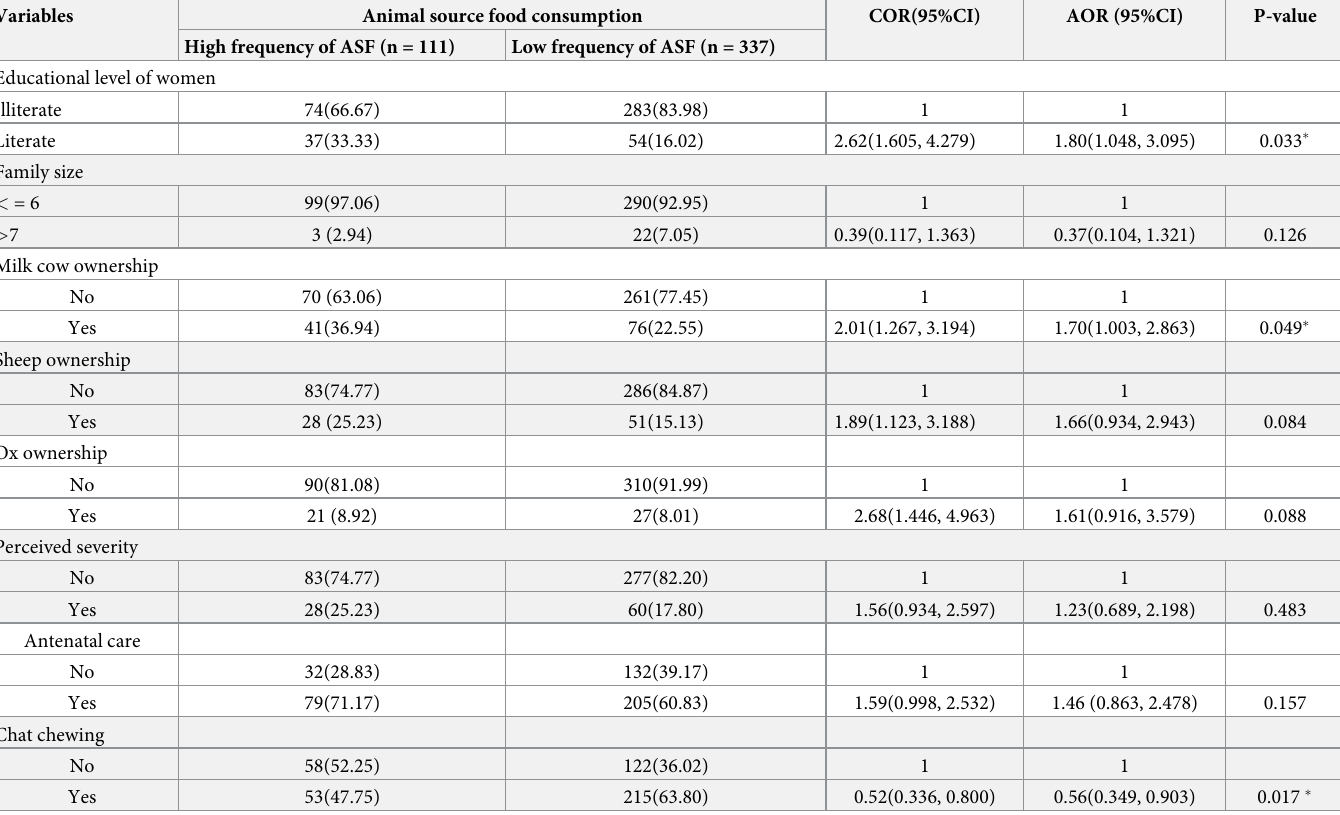
Table 3. Factors associated with animal source food consumption among pregnant women in Eastern Ethiopia, 2021.